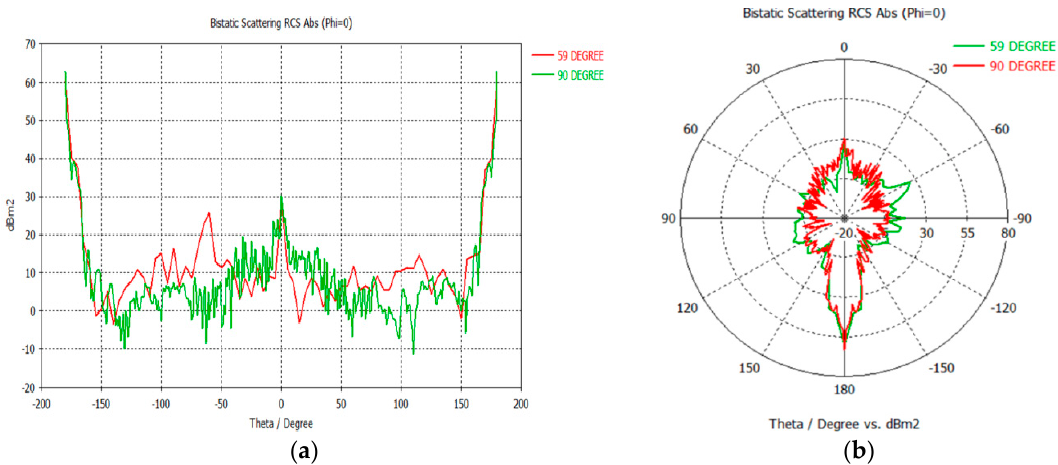
Figure 5. Vehicles’ RCS at two different incident angles: ( a ) Cartesian Plot and ( b ) Polar Plot.